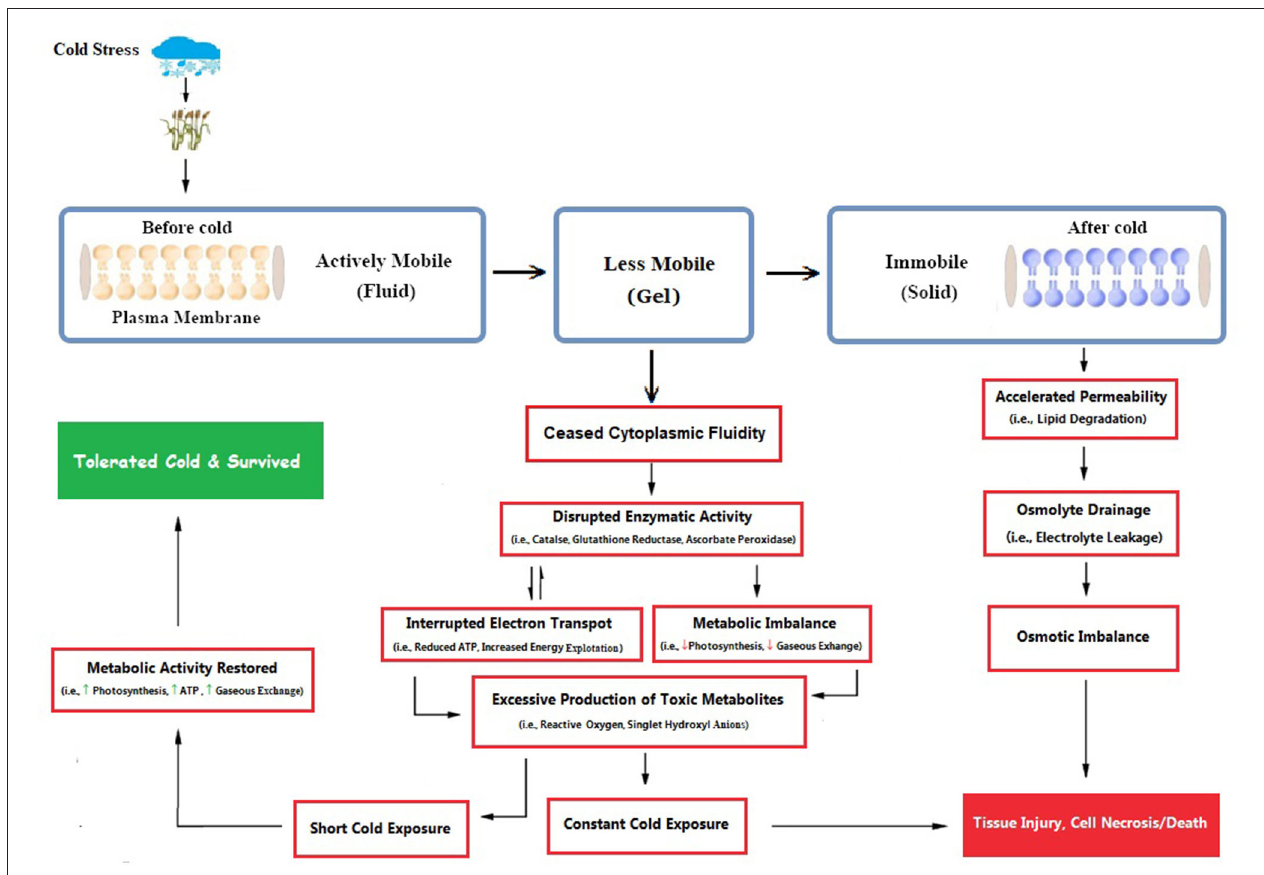
FIGURE 3 | Cold-induced damage is clearly illustrated, as membranes are primarily the first site to get cold damage, followed by a series of osmotic, enzymatic, and metabolic alterations inside the plant cell. Plant cells tolerate shorter cold exposure and restore to normal functioning, but prolonged exposure leads to cell death (Conceived from Seo et al., 2010; Abdel Kader et al., 2011; Theocharis et al., 2012). [Here, ↑ indicates enhanced activity and ↓ shows diminished